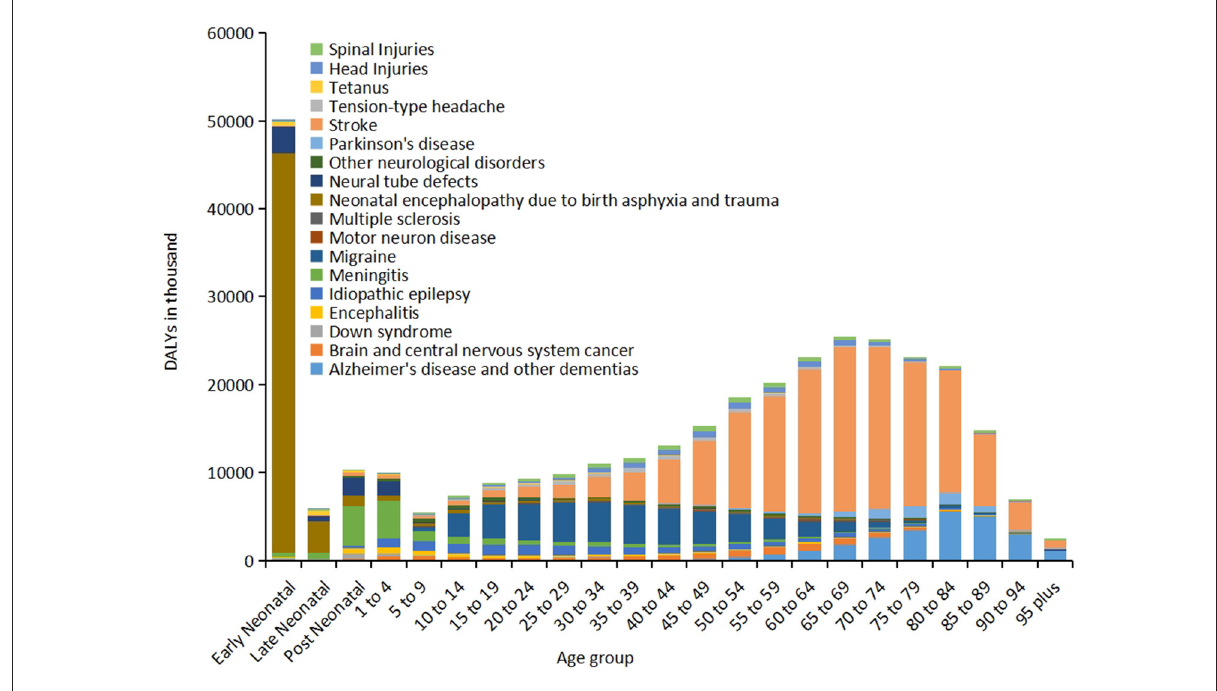
FIGURE4 Distribution of global DALYs for 18 neurological disorders by age,